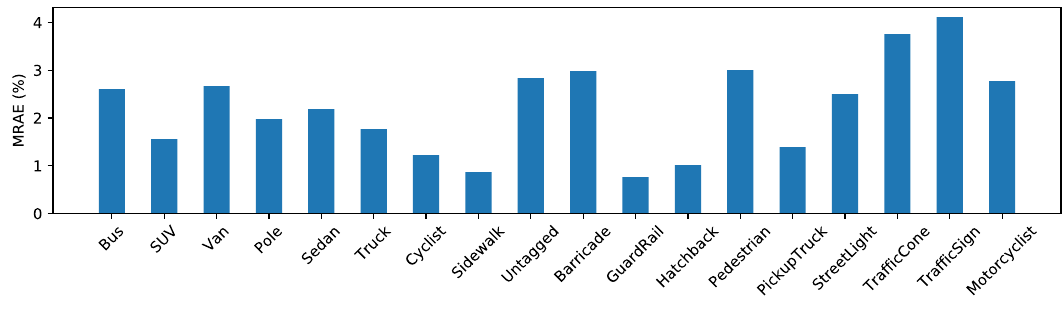
Figure 6. Performance on target objects of various classes.